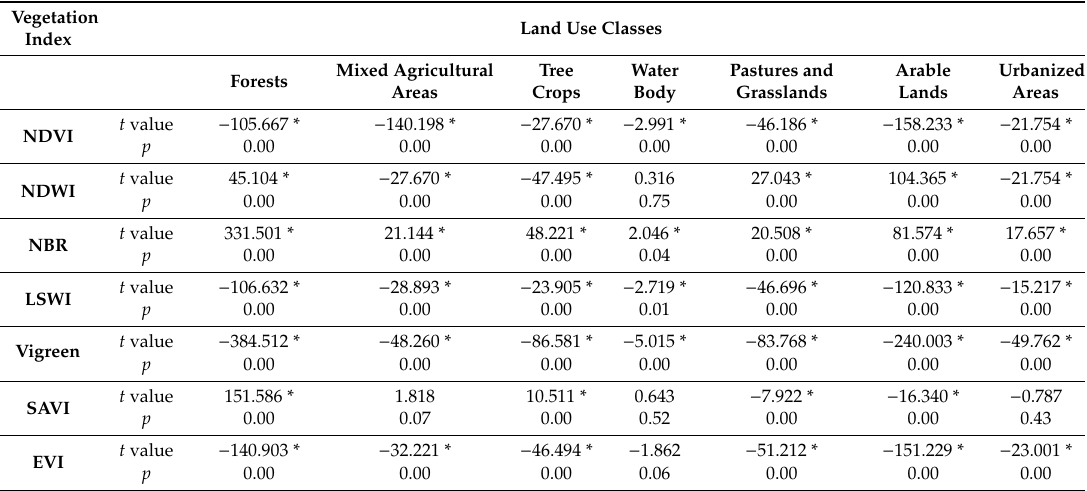
Table 6. Land use class-based Student’s t -test to examine di ff erences between ETM + e OLI sensors for each vegetation index. * Significant di ff erences ( p < 0.05).